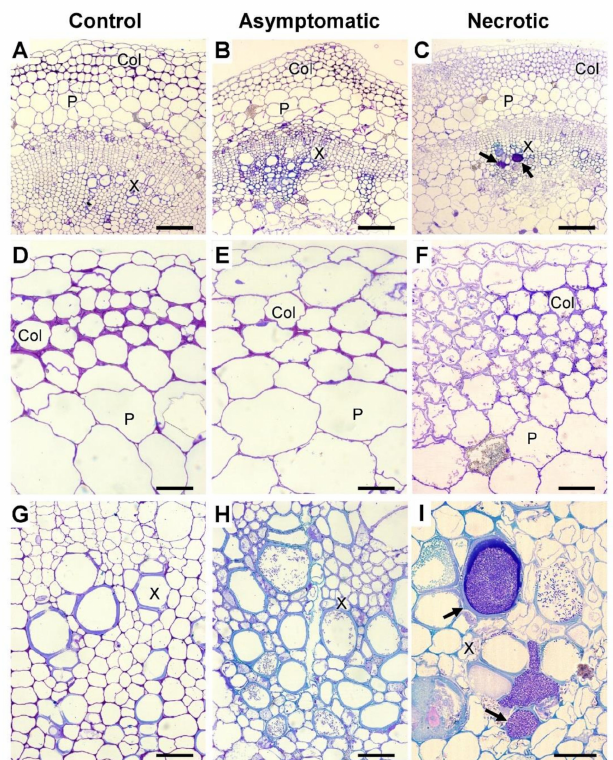
Figure 7. Toluidine blue-stained stem sections of control non-infected ( A , D , G ) and Pectobacterium atrosepticum -infected ( B , C , E , F , H , I ) potato plants; the sections from the infected plants were taken in the asymptomatic ( B , E , H ) and necrotic ( C , F , I ) zones designated in Figure 1. Scale bars: 200 µ m for ( A – C ), 50 µ m for ( D – H ), and 25 µ m for ( I ). Parenchyma (P), collenchyma (Col), and xylem (X). Arrows in C and I show the bacterial emboli in the primary xylem vessels. ( D – F ) are the magnified images of the collenchyma+parenchyma area presented in ( A – C ), respectively. ( G – I ) are the magnified images of the xylem area presented in ( A – C ), respectively. The samples were analyzed in three biological replicates.